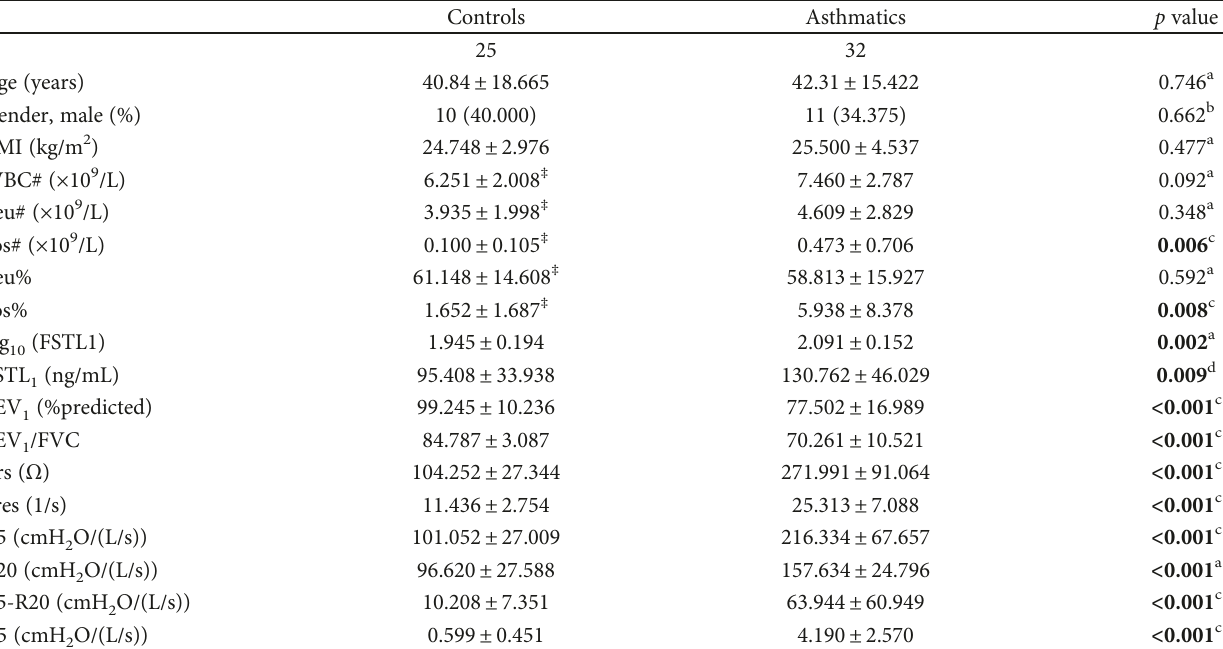
Table 1: Patient